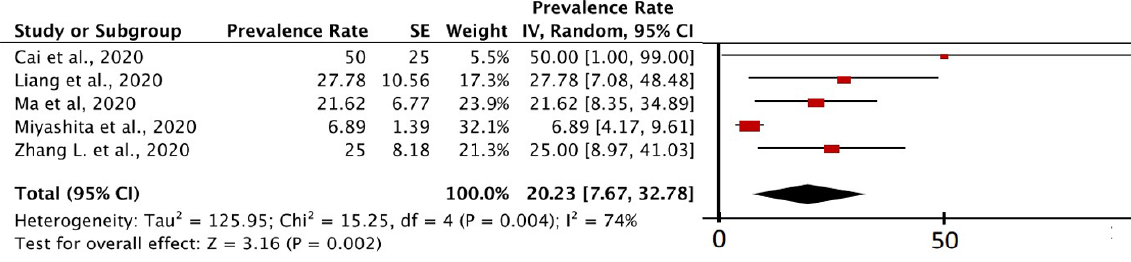
with cancer as a comorbid (43.26%, 95% CI, 34.71% –